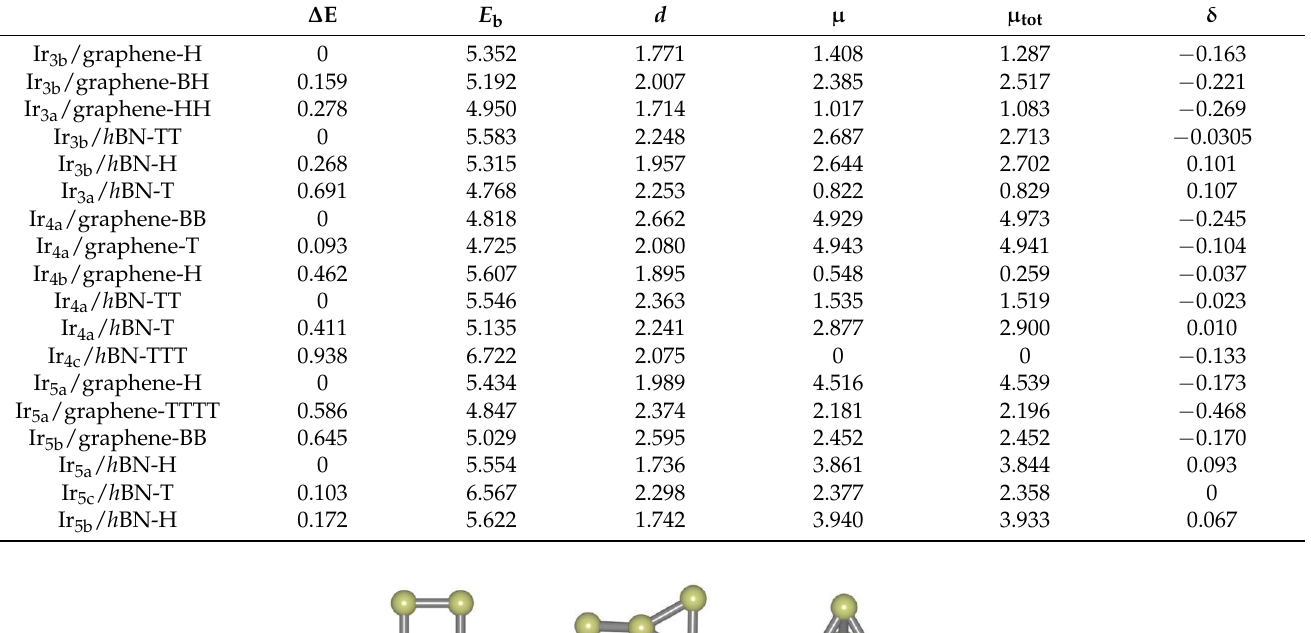
Table 1. The energy difference between the most stable configuration and its isomer ( ∆ E, eV), the binding energy ( E b , eV), the minimum distance between the cluster and the substrate ( d , Å), the magnetic moment of the clusters ( µ , µ B ) and the hybrid system ( µ tot , µ B ) and the transferred charge from the cluster to the 2D substrate ( δ , e ). The negative δ represents the electrons transferring from the cluster to the 2D substrate.